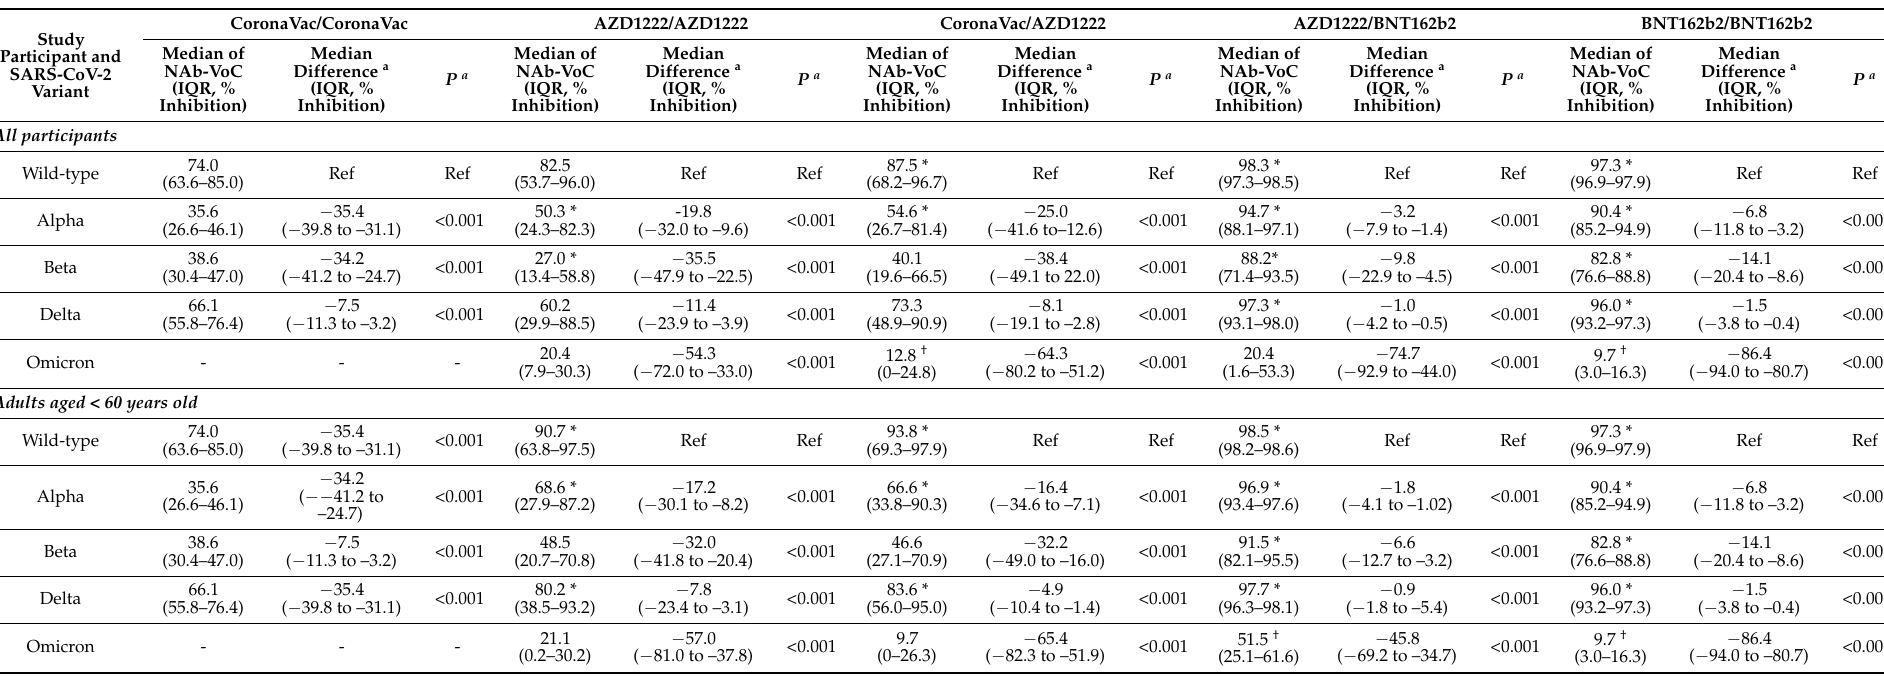
Table 4. The median of neutralizing antibodies, based on the in-house surrogate virus neutralization test, against wild-type and other circulating variants of concern of SARS-CoV-2 following the completion of a primary series of COVID-19 vaccination, stratified by the COVID-19 vaccine